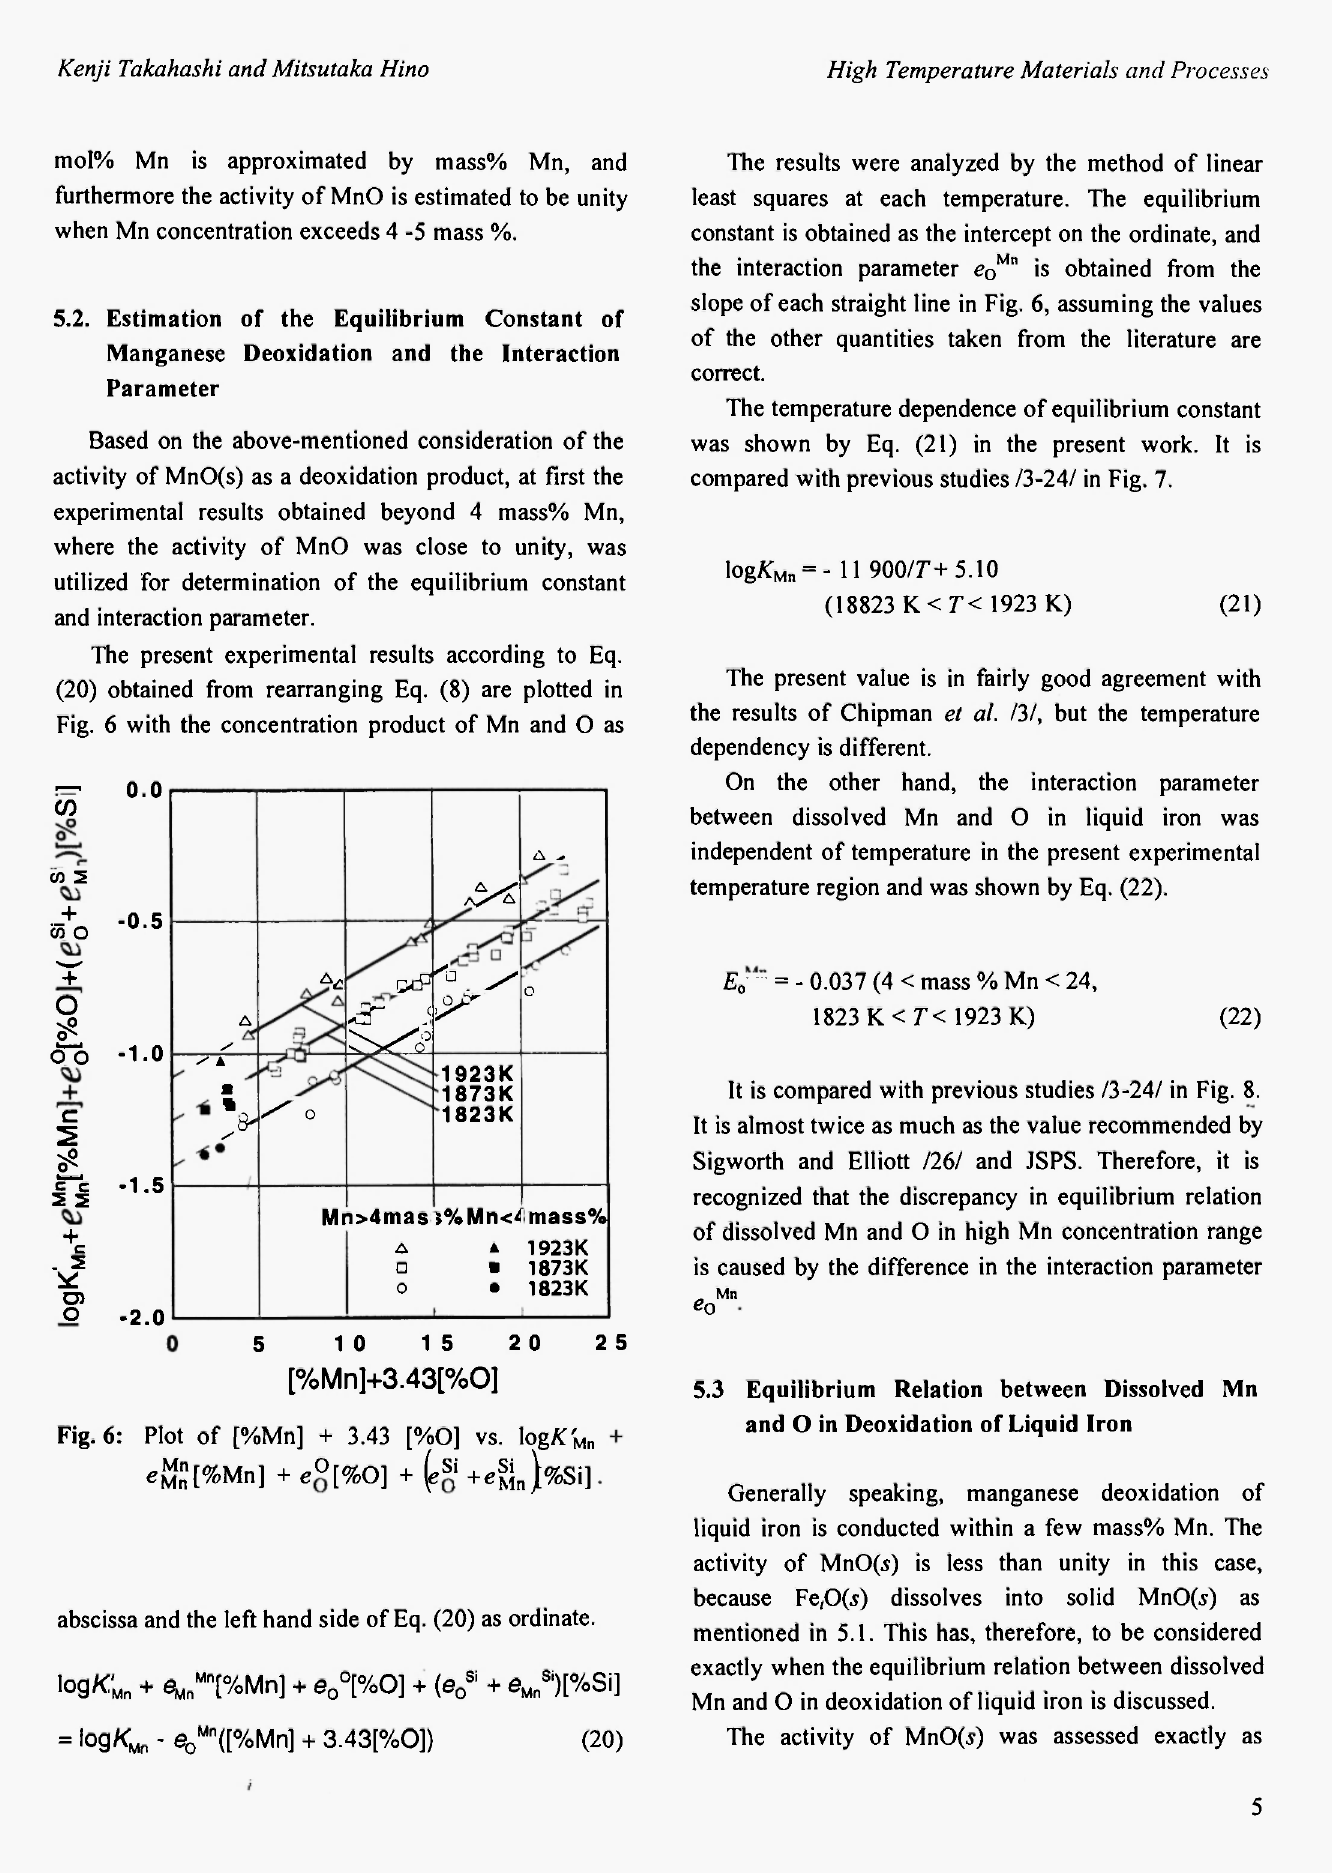
Fig. 6: Plot of [%Μη] + 3.43 [%0] vs. logAT' Mn e£J n "[%Mn] + e ° [ % 0] + (e* +egj„)%Si]